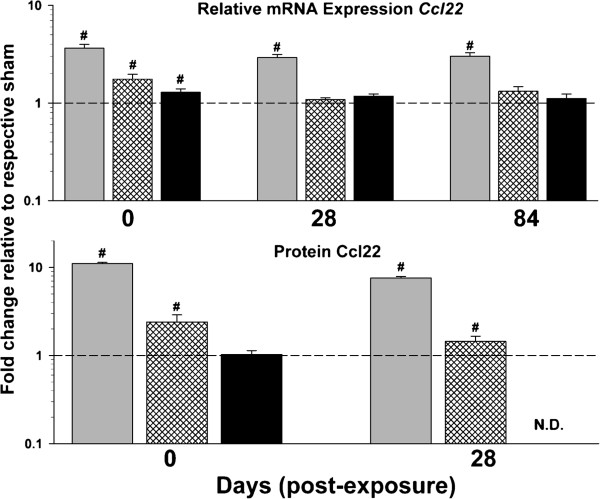
Effect of multi-walled carbon nanotube (MWCNT) inhalation on pulmonary chemokine (C-C motif) ligand 22 (Ccl22) at different time points after exposure. Pulmonary tissue gene expression (upper panel) and protein levels from the first fraction of collected bronchoalveolar lavage fluid were measured. Data are expressed as percent (%) change from respective sham (dashed line – 100%). Data presented as high dose (gray bars), medium dose (pattern), and low dose (black bars). N.D. – not determined. *p<0.05 vs. respective sham; #p<0.05 vs. other MWCNT depositions for a given time point only.